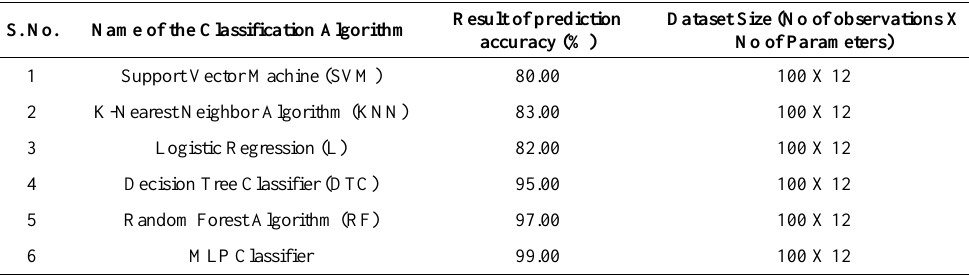
Table 4. Validation results on dataset by various classification